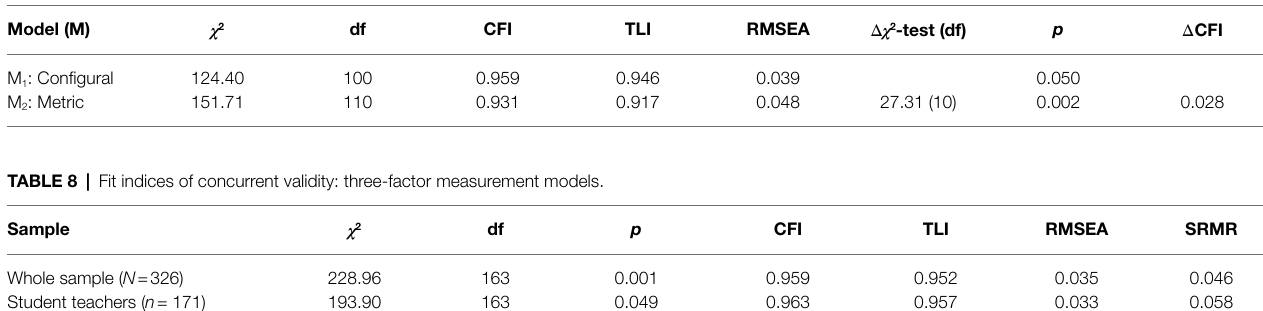
TABLE 7 | Fit indices of Closeness and Conflict: measurement invariance models. Model (M) χ 2 df CFI M 1 : Configural